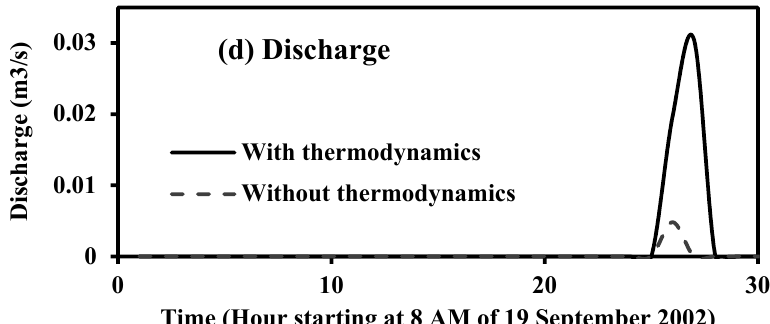
Figure 10. Catchment hydrological modeling with and without soil thermal dynamics during September 2002; ( a ) simulated and observed soil temperature ( b ) precipitation ( c ) simulated infiltration with and without soil thermodynamics ( d ) simulated discharge with and without thermodynamics.